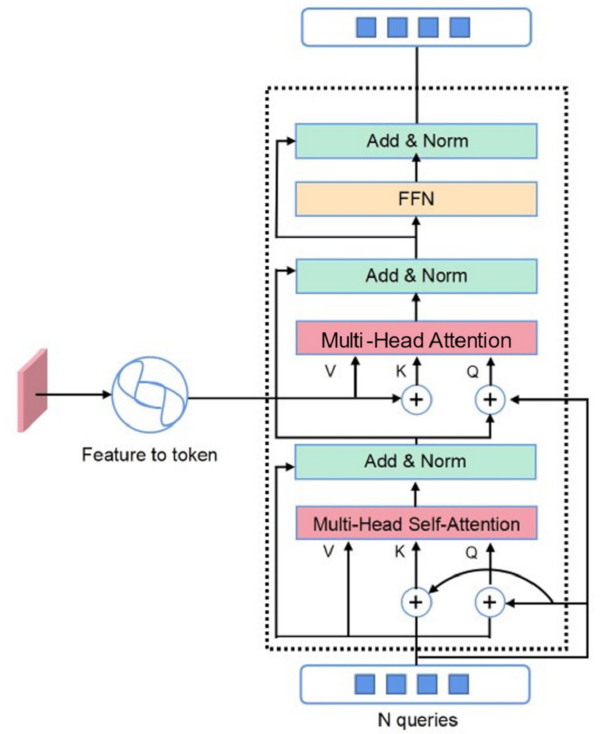
Figure 5. The Transformer module consists of a standard Transformer decoder and a feature con- verter. To strengthen the position information between the features, the feature converter uses an asynchronous position